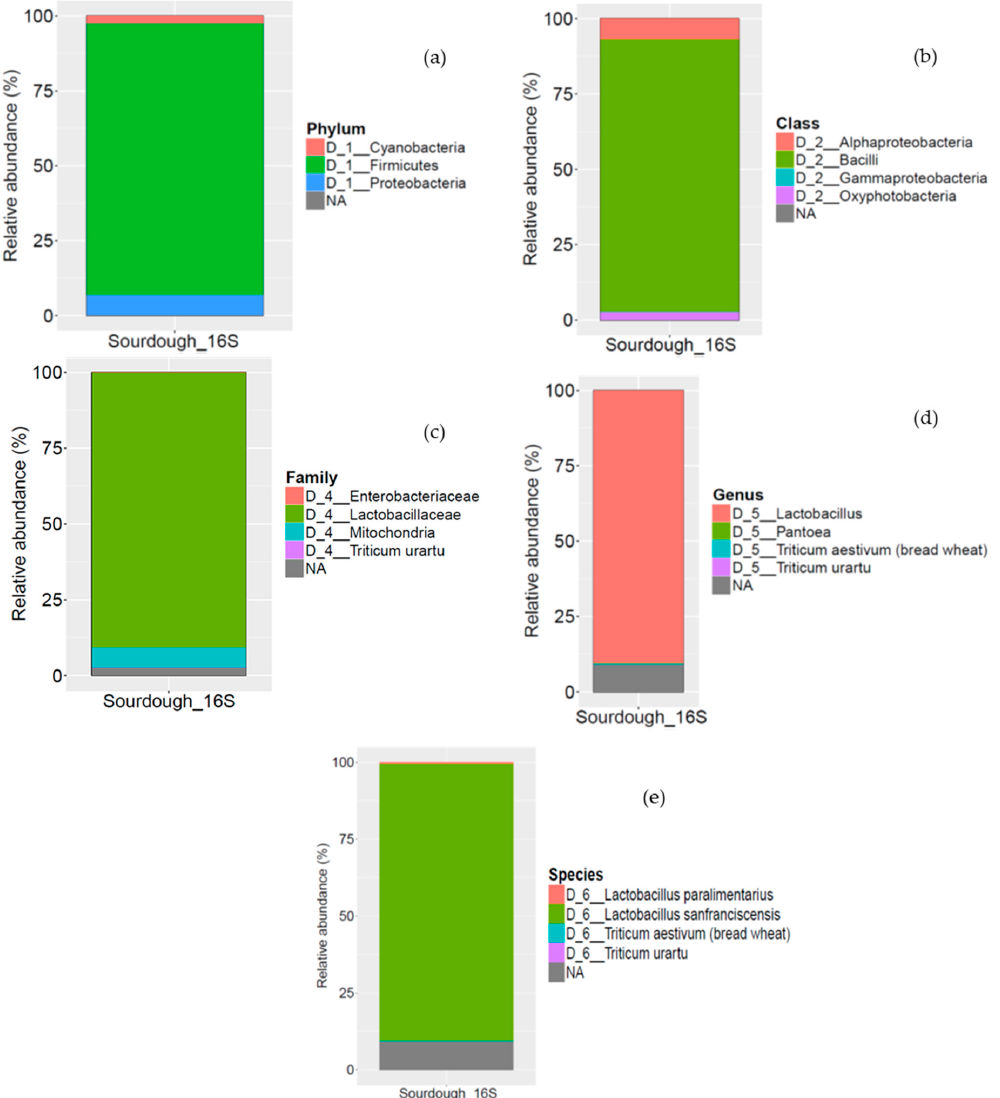
Figure 2. Analysis of prokaryotic community in sourdough ( a ), distribution of the major bacterial phyla, ( b ) distribution of the major bacteria at the class level, ( c ) distribution of the major bacteria at the family level, ( d ) distribution of the major bacteria at the genus level, and ( e ) distribution of the major bacteria at the species level. The scale in the y-axis reflects the normalized relative abundance percentages.